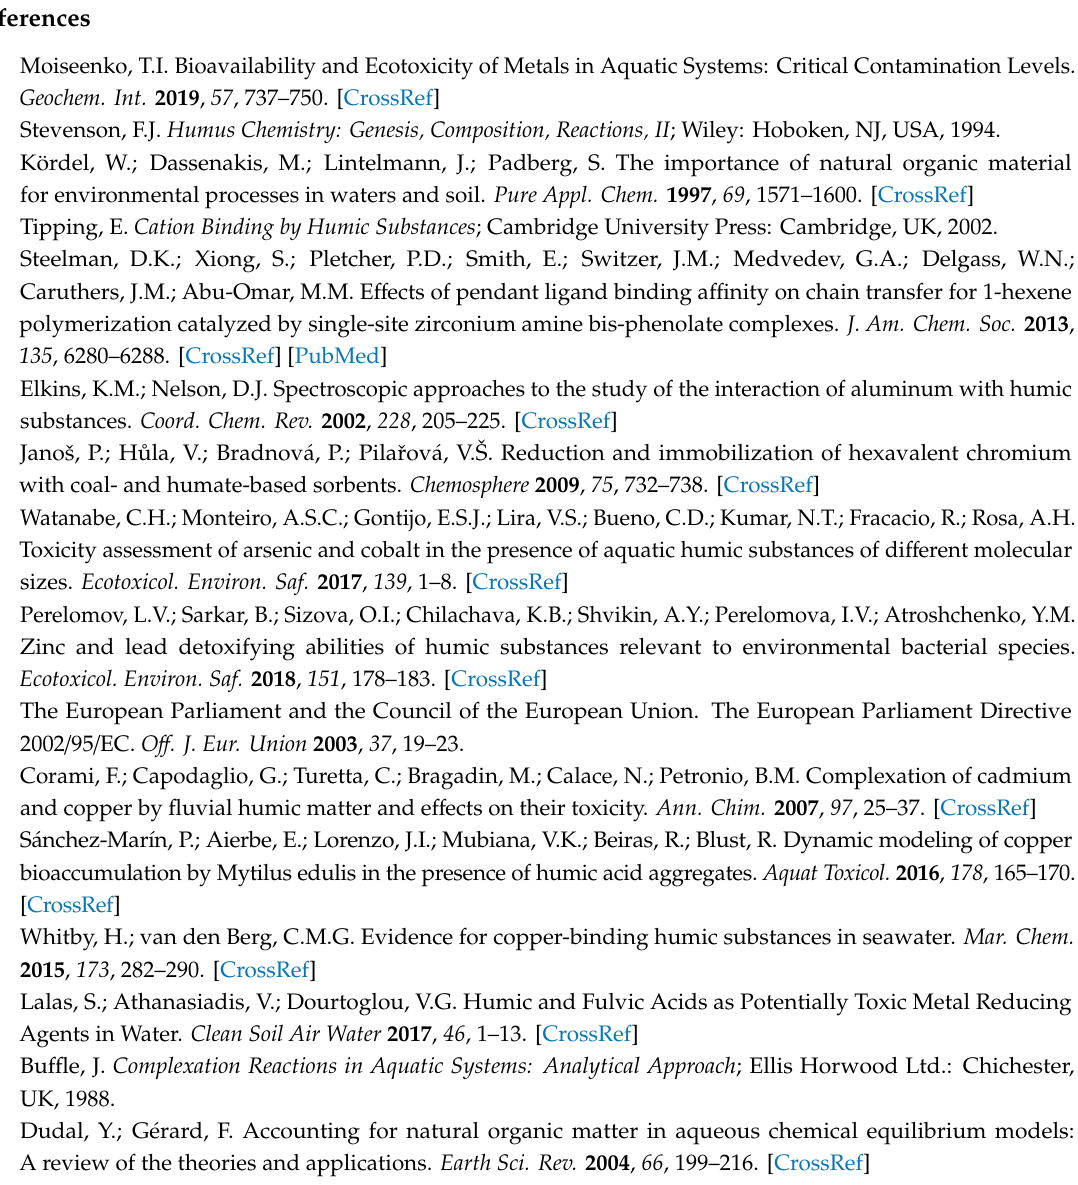
parameters for the ICP-MS